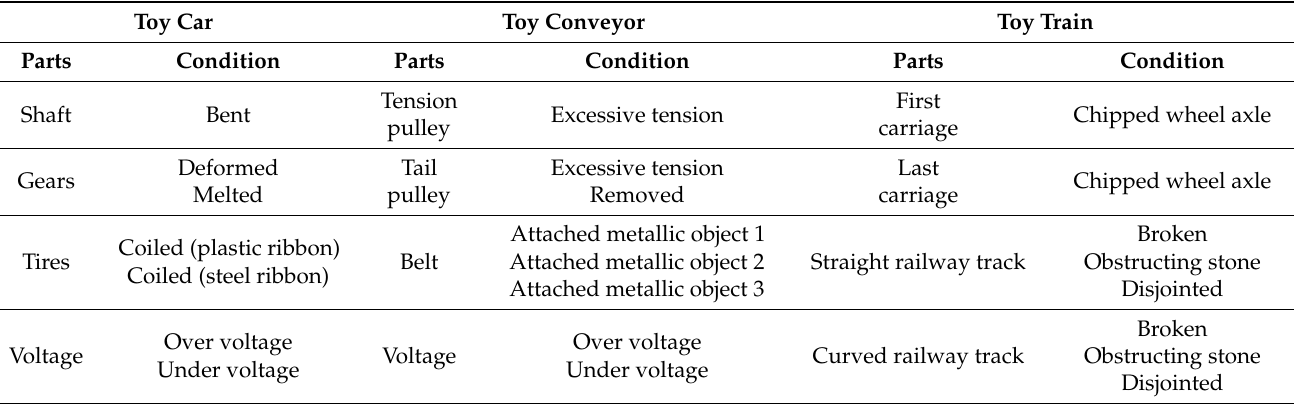
Figure 12. Schematic of microphone installation setup for ToyADMOS miniaturised machines ( a ) toy car ( b ) toy conveyor ( c ) toy train [9]. Table 7. Imbedded faults in ToyADMOS miniaturized machines [9].